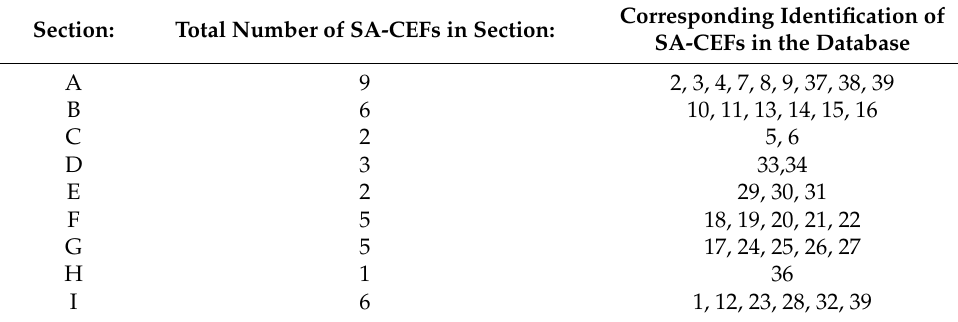
Table 1. Summary table of SA ‐ CEFs within each section for further data processing.